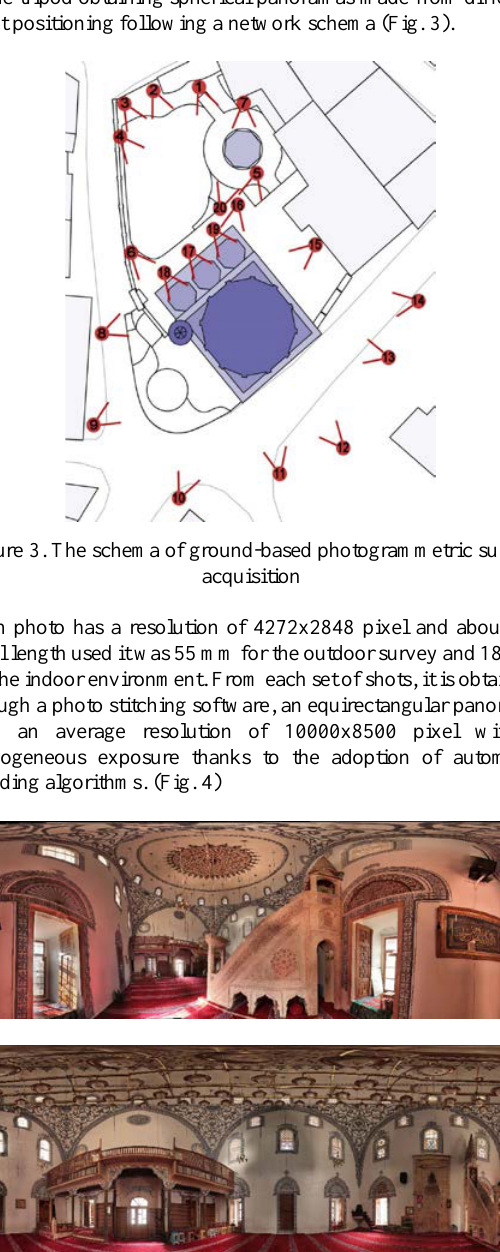
Figure 4. Examples of equirectangular panorama of indoor